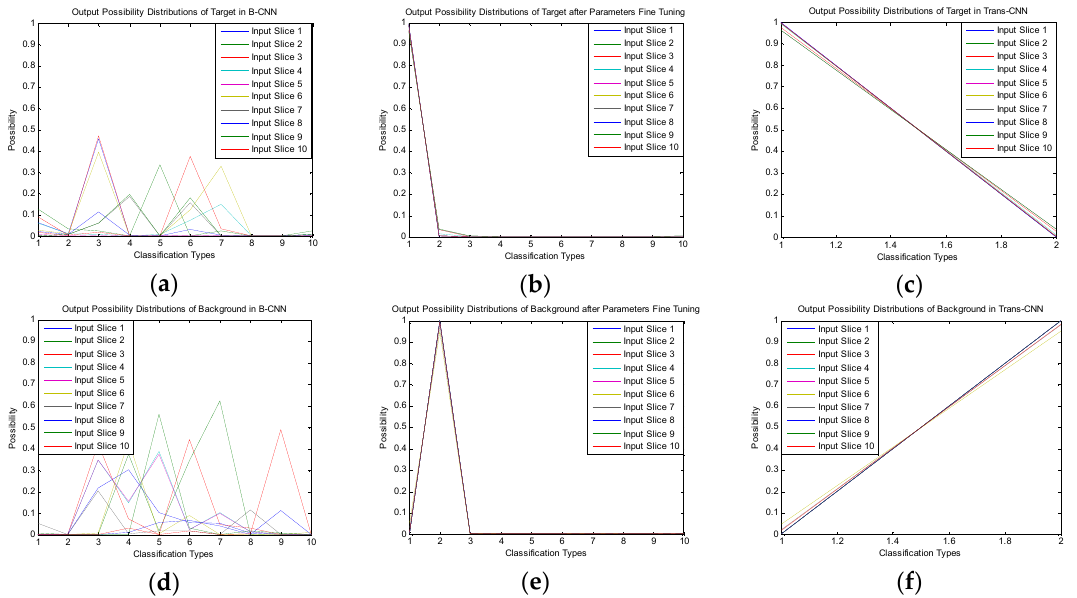
Figure 5. The target or background slices of output label distribution in networks. ( a ) B_CNN / target, ( b ) Parameters after fine-tuning in B_CNN / target, ( c ) Trans_CNN / target, ( d ) B_CNN / background, ( e ) Parameters after fine-tuning in B_CNN / background, ( f ) Trams_CNN / background.